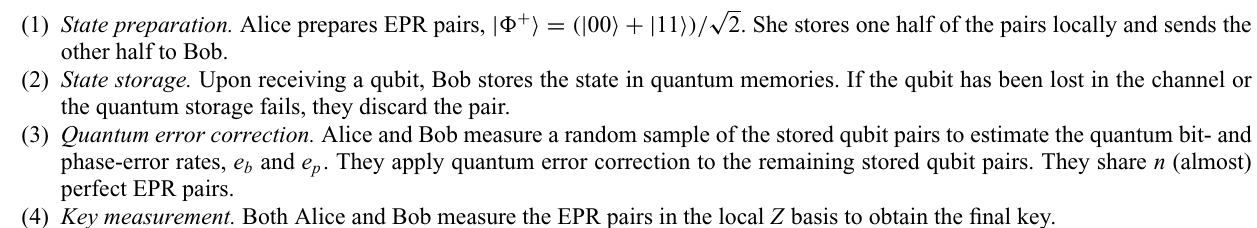
TABLE II. BBM92 protocol [29], an entanglement version of